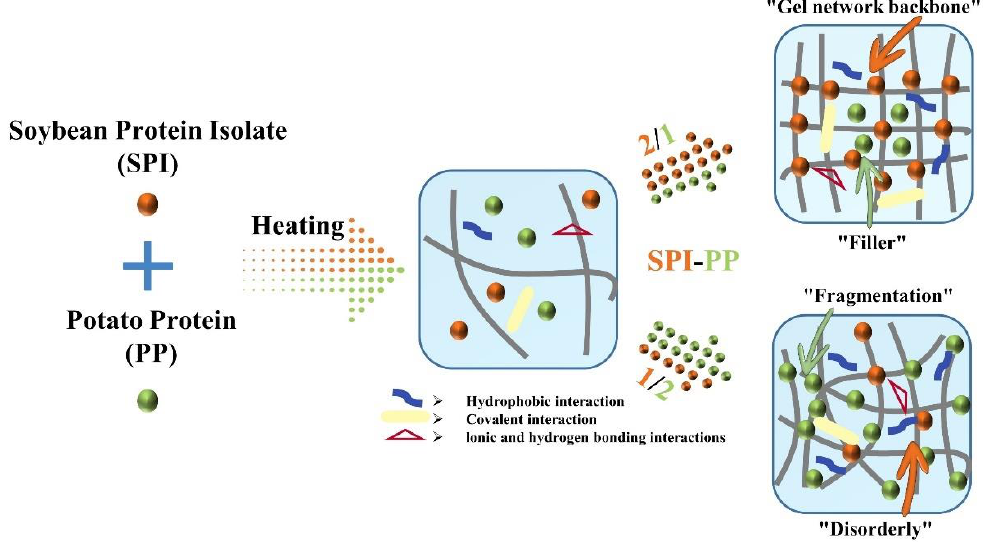
Figure 8. Scanning electron microscopy of composite gels at different SPI and PP ratios. ( a ) SPI-PP